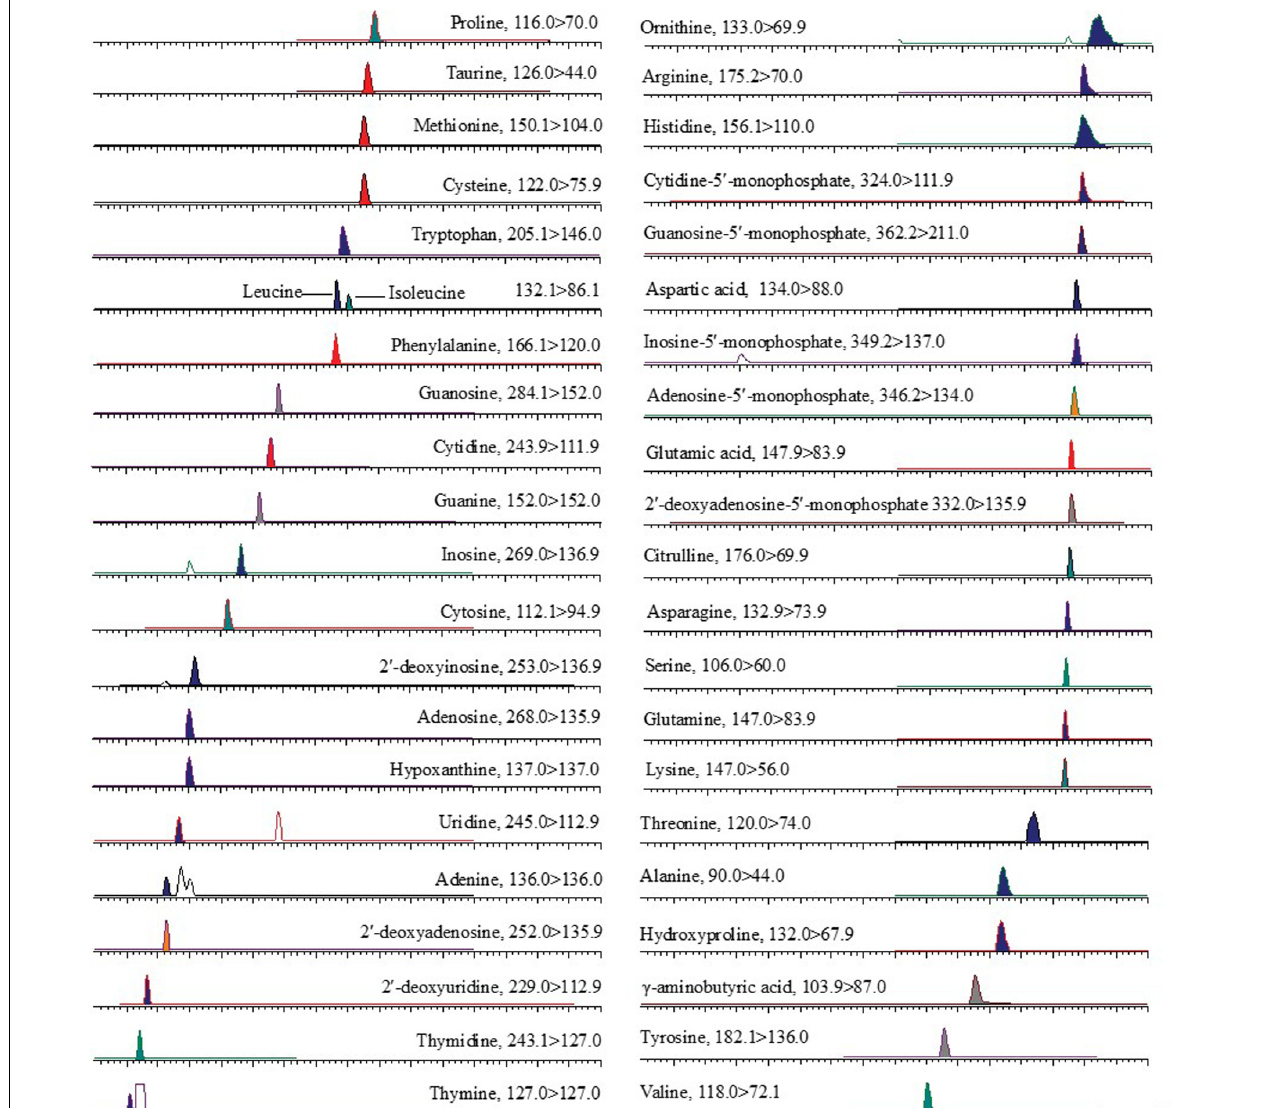
FIGURE 2 | Ultra-high performance liquid chromatography coupled with triple-quadrupole mass spectrometry (UHPLC-TQ MS) chromatography (MRM/SIM) of mixed standards for amino acids, nucleosides, and nucleobases analyzed in the present study.